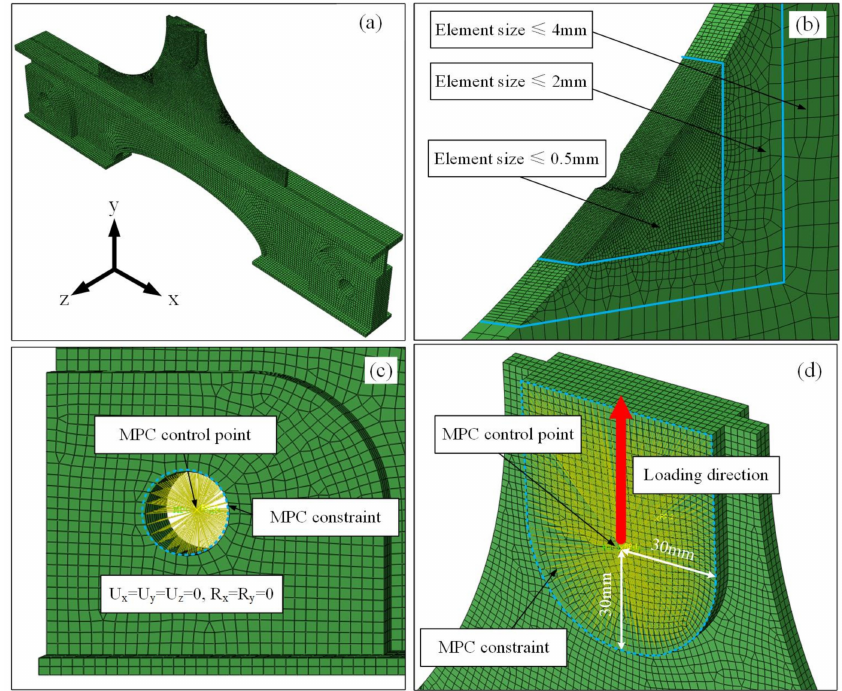
Figure 7. ( a ) The FE model of the hatch corner, ( b ) the local mesh refinement around arc notch, ( c ) the boundary conditions of the FE model, ( d ) setting of the loading side.